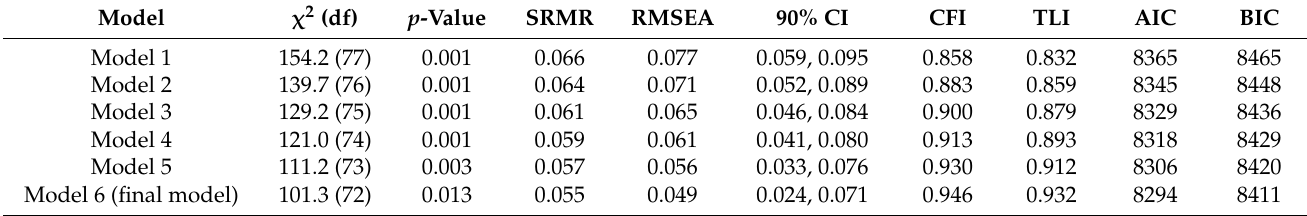
Table 3. Comparison of fit indices among the CBS-M models.